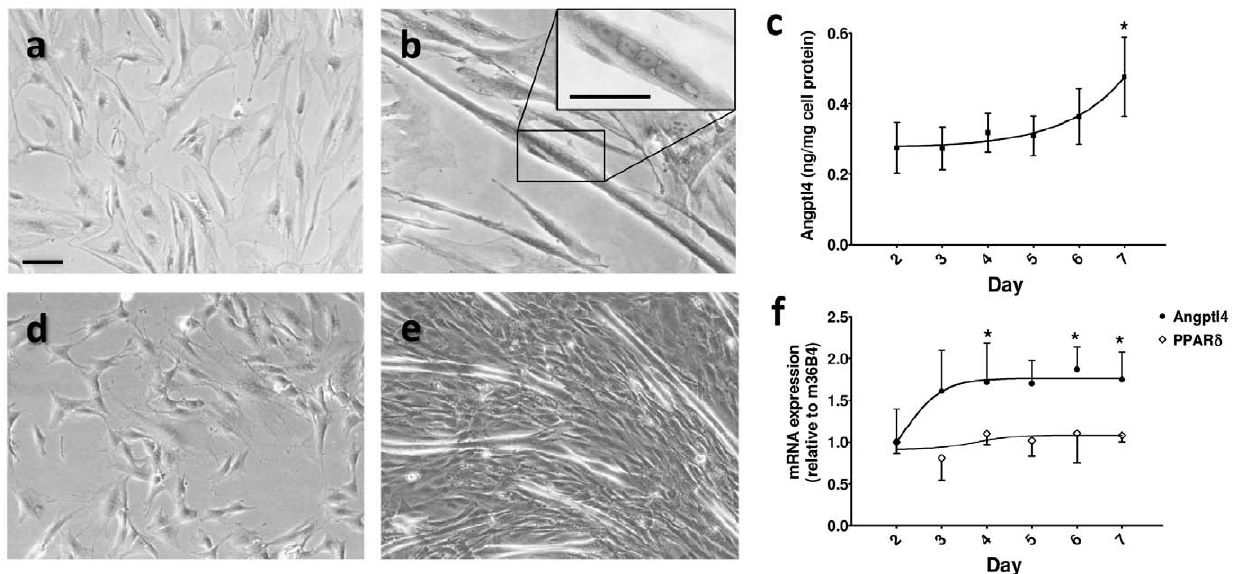
Figure 1. Angptl4 mRNA and protein levels are increased during differentiation of myotubes. Proliferative myoblasts from human ( a ) and mouse ( d ) C2/LPL were differentiated in multinucleated ( b , inset) myotubes ( b , human and e , mouse) and visualized using conventional light microscopy. ( c ) Secretion of Angptl4 was quantified by ELISA from day 2 to day 7 of differentiation and adjusted for protein content in cells derived from three men. ( f ) Angptl4 and PPAR d mRNA levels were measured by real time PCR during differentiation of C2/LPL myoblasts, n=4. Values are expressed as fold increase relative to day two of differentiation and normalized to human b -actin or mouse 36B4 mRNA levels. Results are expressed as mean 6 SEM, ( c ) n=3 and ( f ) n=4. Scale bar: 50 m m. *p , 0.05 as compared with day 2 using Repeated Measures ANOVA with Dunnett’s post